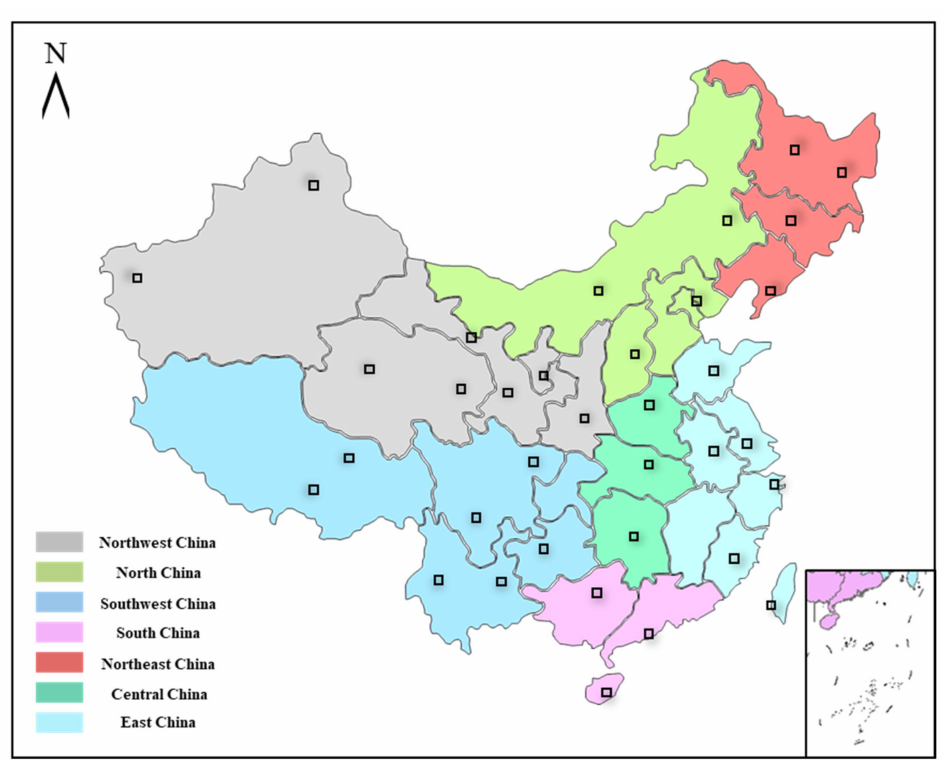
Figure 3. Where “ (cid:3) ” denotes a sampled Sentinel-2 image in 2020 of 10,980 × 10,980 pixels within 100 km × 100 km area in the constructed dataset with